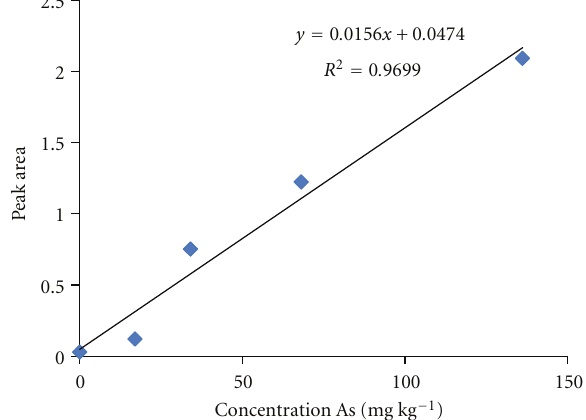
Figure 1: Calibration for solid sample determination by GFAAS.